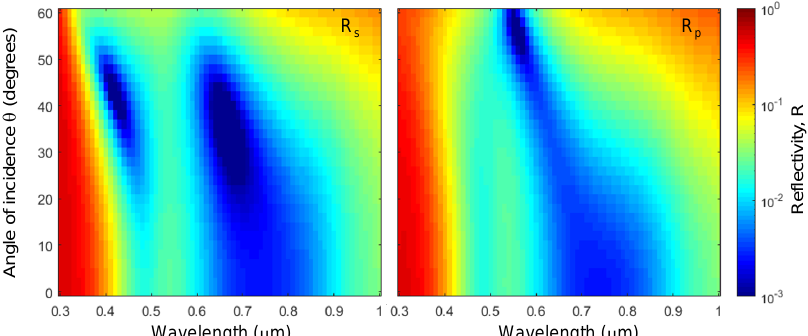
Figure 3. Plots of the simulated of reflectivity for s- and p-polarisations R s , R p at different angles of incidence 0–60 θ within the 0.3–1 µ m spectral window. The stack was SiO d 1 = 84.8 nm, d 2 = 7.9 nm, d 3 = 93.7 nm on a 100-nm-thick Ti mirror on a soda lime glass substrate (see stack geometry in Figure